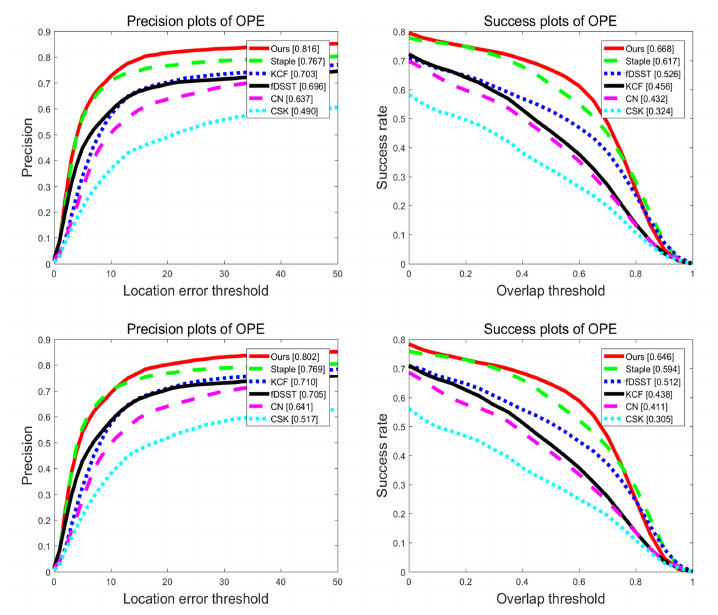
Figure 4. The precision and success plots of OPE on OTB-13 and OTB-15.